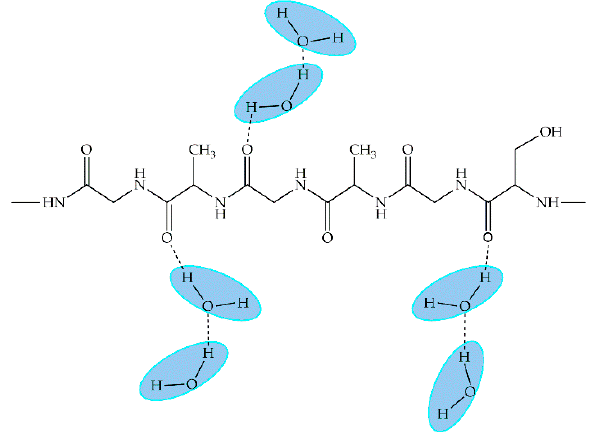
Figure 18. Proposed structure of intermediate water sorbed on silk fibroin.